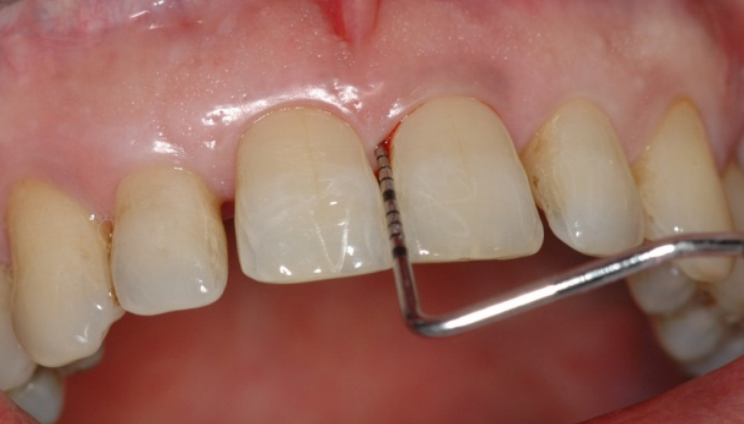
Figure 1. Bleeding on Probing (BoP): Blood coming out during probing is at this time the unique predictive test used by periodontists.